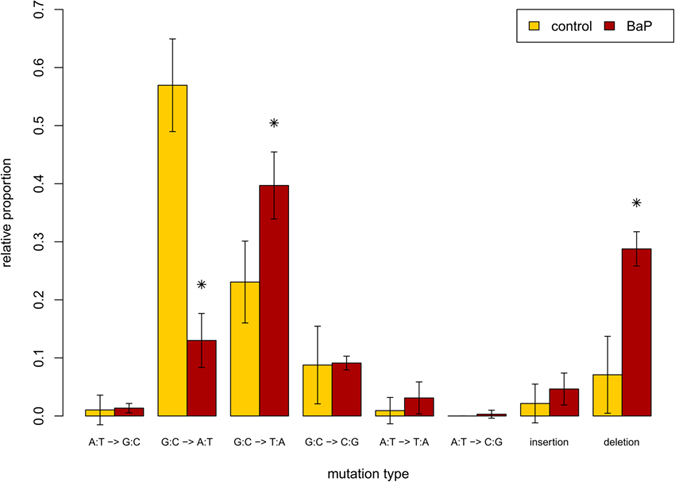
The proportion of all independent spontaneous (control) and benzo[a]pyrene (BaP)-induced lacZ mutations detected in sperm collected 42 days after the treatment period.*Indicates significant differences (p < 0.05) between control and BaP groups.